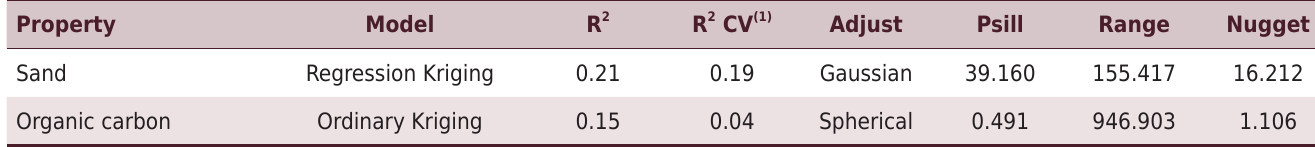
Table 2. Model type and parameters of the semivariograms developed for the soil properties studied in Keller Peninsula Property Model R 2 R 2 CV (1) Adjust Psill Range Nugget Sand Regression Kriging 0.21 Organic carbon Ordinary Kriging